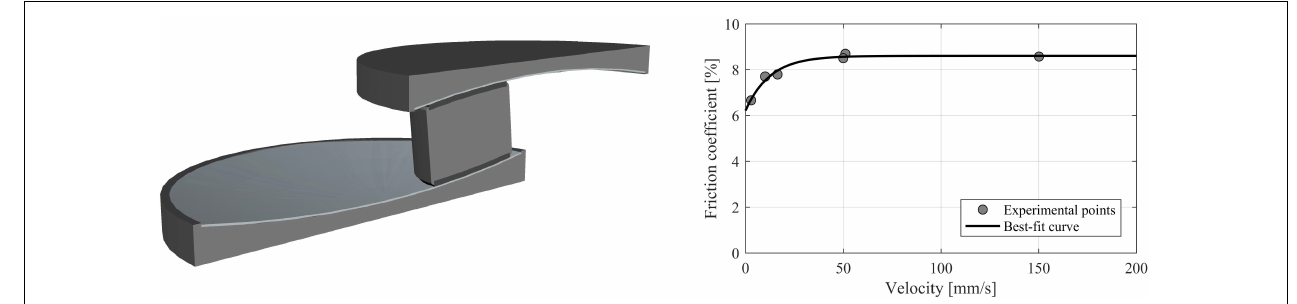
FIGURE 4 | Tested isolator and frictional characterization